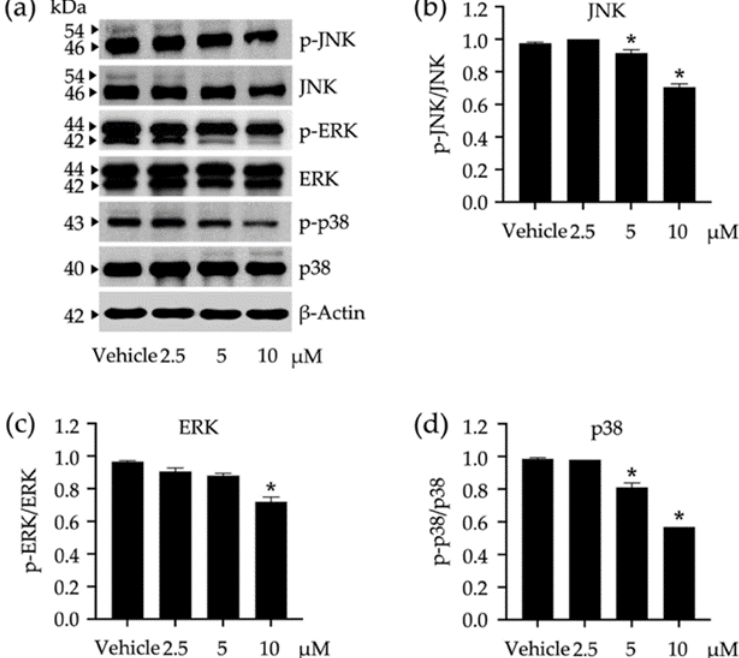
Figure 5. Impacts of compound 3 on the activation of c-Jun N-terminal kinase (JNK), extracellular signal-regulated kinase (ERK), and stress-activated protein kinase (p38) in 3T3-L1 cells. The band intensities of these kinases were visualized by Western blotting assay ( a ) and used for calculating their expression relative to β -Actin as a reference protein. The expression ratio between phosphorylated analog (p-JNK, p-ERK, and p-p38) and the summary (phosphorylated + non-phosphorylated) of each kinase was accounted for to describe the activation level ( b – d ). Non-cytotoxic concentrations (2.5, 5, and 10 µM) of compound 3 were used in this study. The graphical results demonstrate means ± SDs derived from three independent experiments. The asterisk (*) represents a statistical difference at p < 0.05 between the treatment and untreated vehicle control made of 0.5% ( v / v ) dimethyl sulfoxide, assessed by one-way ANOVA with Tukey’s post hoc test.